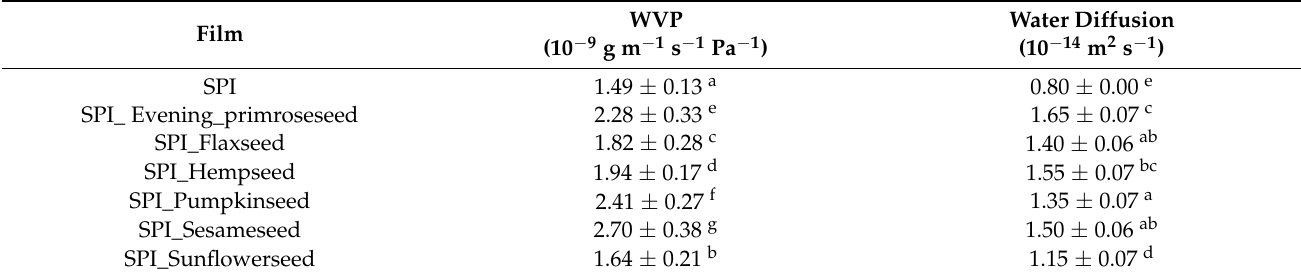
Table 3. Water vapor permeability (WVP) at relative humidity difference of 50–100% and water diffusion of soy protein isolate–oilseed flour films.